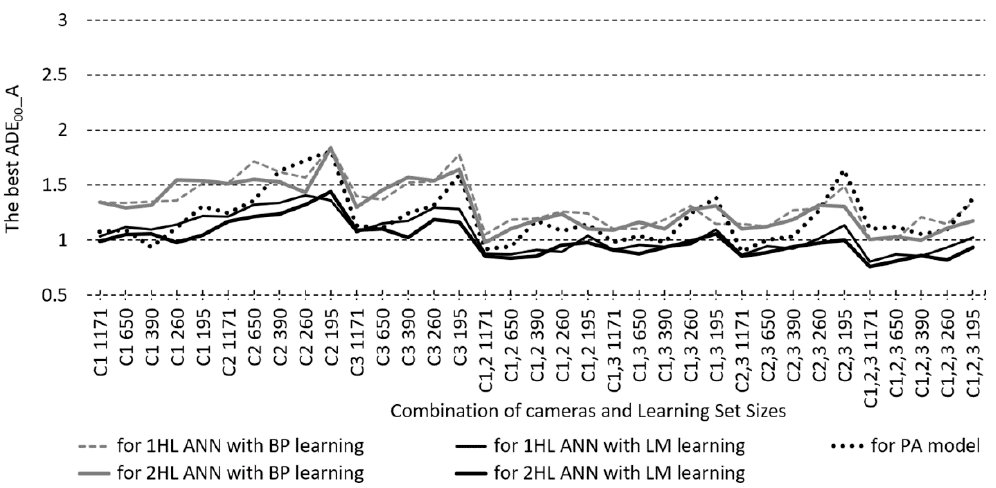
Figure 10. Comparison of the best test set average CIEDE2000 colour differences with illuminant A (A ∆ E* 00 _A) for ANN and PA models, according to one and two hidden layer ANNs (1/2HL) modelled with BP or LM learning algorithm and for the polynomial approximation models (PA).